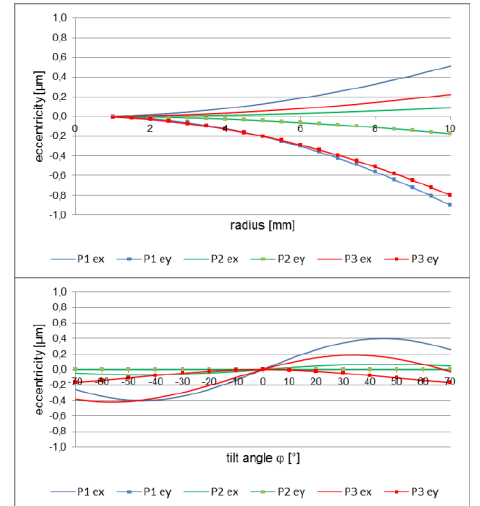
Figure 7: Eccentricity in projection of circular targets as a function of target radius (left) and tilt angle (right, with r =5mm) Figure 7 (bottom) displays the result of tilt angle variation for a target of 5mm radius. In this example the angle j is altered between –70 and +70 degrees while  =0. The eccentricity ex behaves like a sine curve with a maximum between 45° and 60° depending on target position. For targets P1 and P2 there is no eccentricity ey since the points are located on the optical axis and  is zero. P3 is located away from the optical axis and leads to sinusoidal eccentricities ex that are symmetrical with respect to the sign of j